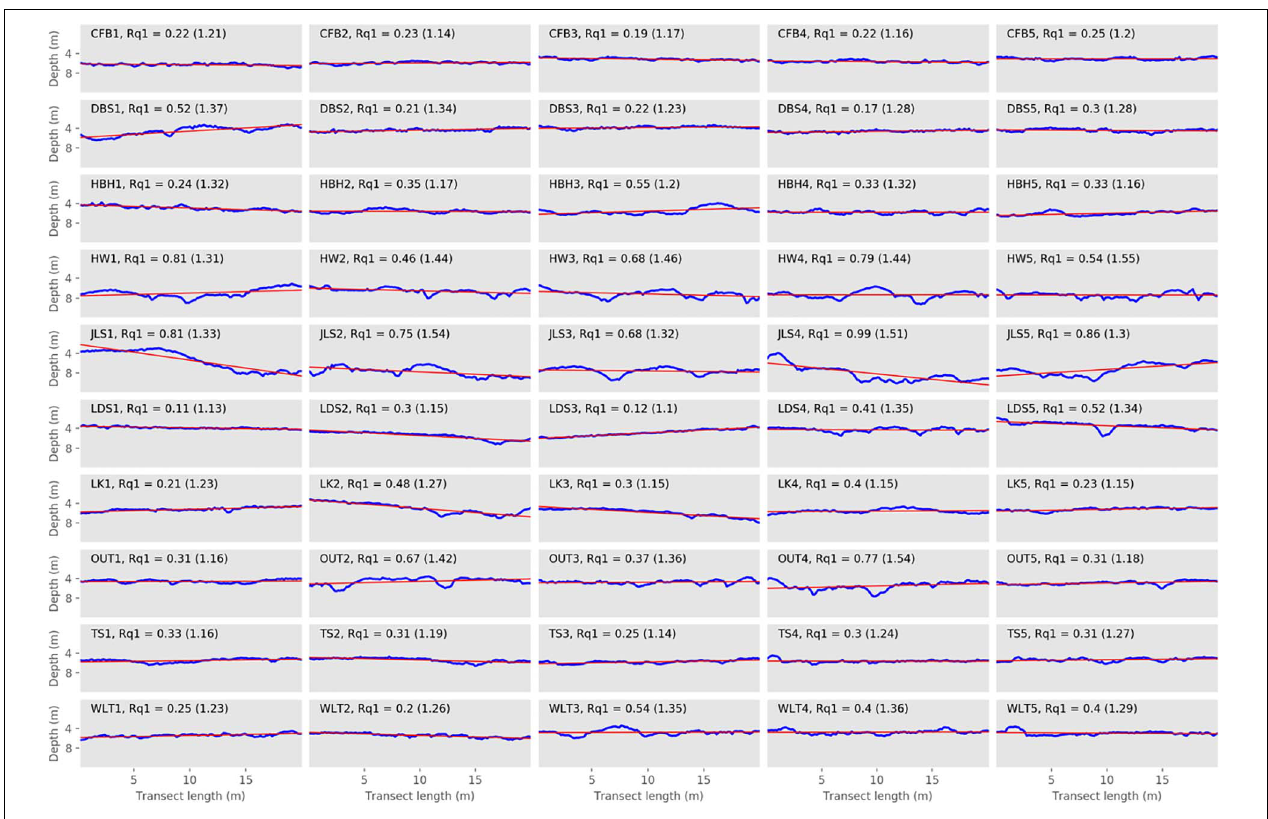
FIGURE 4 | Depth profiles of the surveyed transects along with their first order of polynomial. Elevation profiles (blue lines) for each transect from the 10 surveyed sites in 2015. Red lines represent the first order polynomials. Chain index results are reported in parentheses.